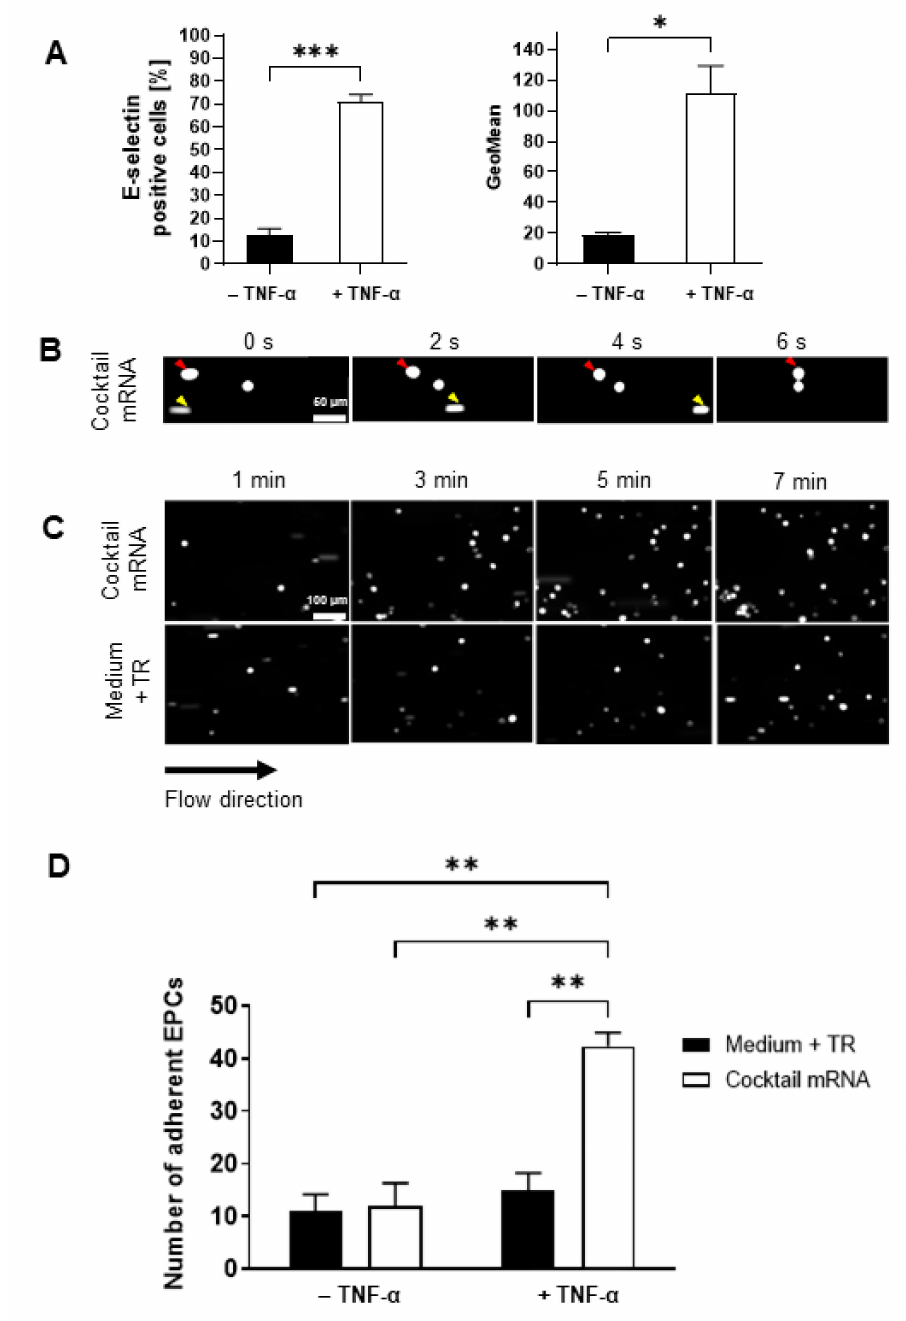
Figure 5. Dynamic adhesion of mRNA-modified EPCs to activated endothelium. ( A ) HUVECs were treated with 10 ng/mL TNF- α , and E-selectin expression was analyzed by flow cytometry to